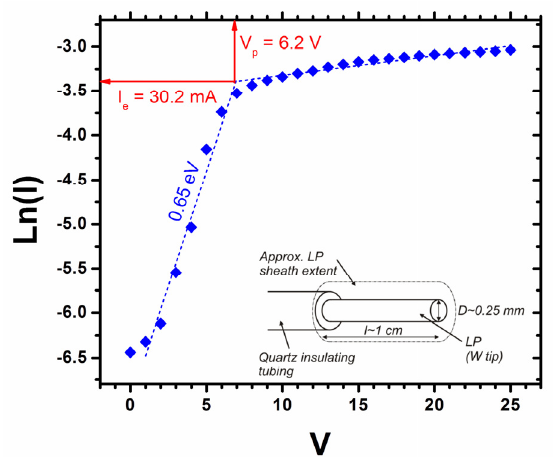
Figure 4. A typical Langmuir probe measurement (30 W, 3.3 mbar) showing the